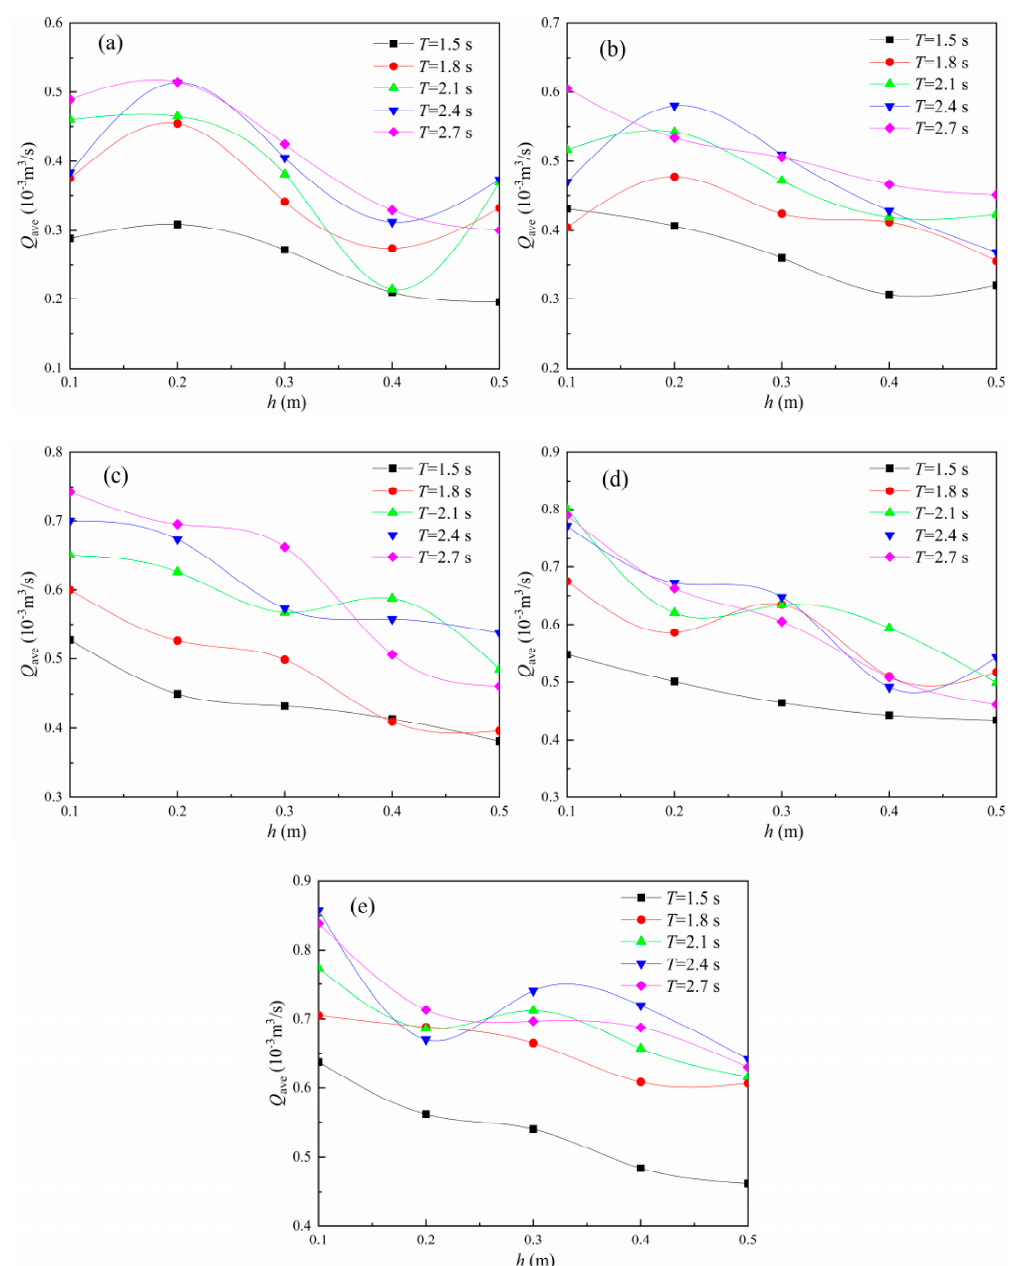
Figure 8. Q ave relationship with h . ( a ) H = 0.18 m; ( b ) H = 0.20 m; ( c ) H = 0.22 m; ( d ) H = 0.24 m; ( e ) H = 0.26 m.